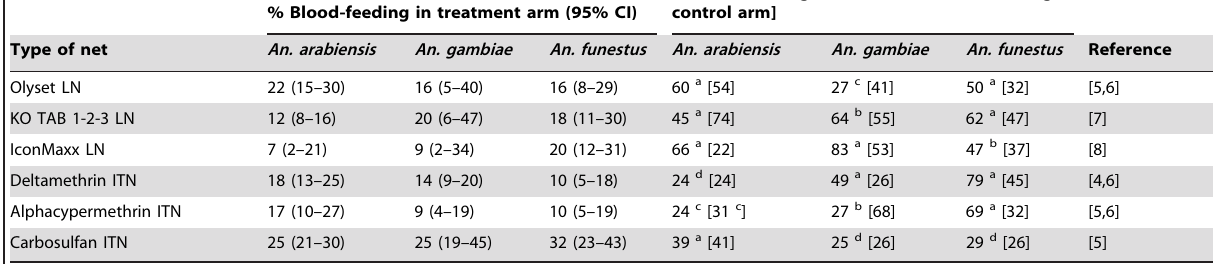
% Blood feeding inhibition* [% Blood feeding in control